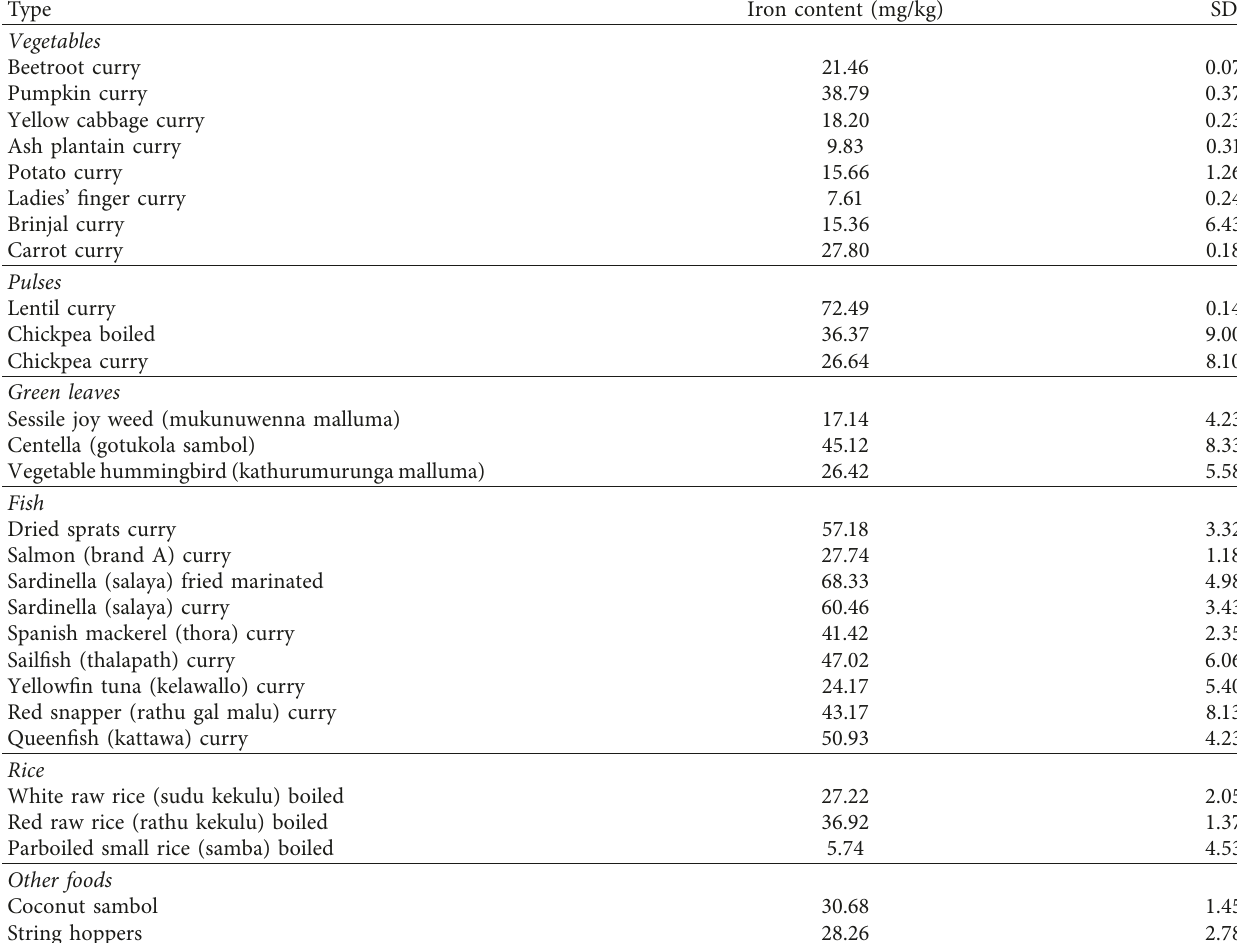
Table 3: Average iron content of cooked food varieties consumed by the adolescents (15-16 years) in the Divisional Secretariat, Horana.